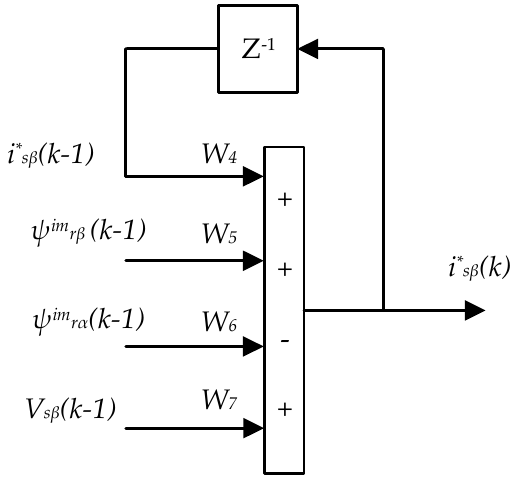
β -axis stator current estimation using artificial neural Figure 4. β - axis stator current estimation using artificial neural network. Figure 4. Figure 4. β - axis stator current estimation using artificial neural network.